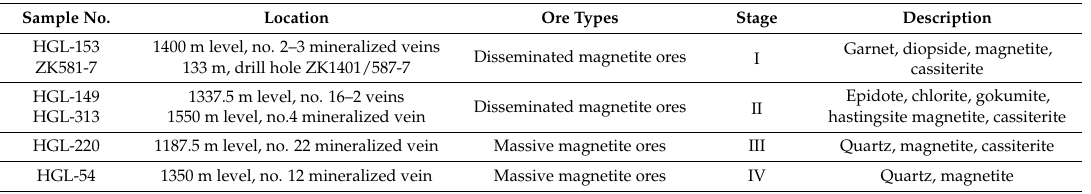
Table 1. Location and descriptions of samples from the Huanggangliang deposit. Sample No.